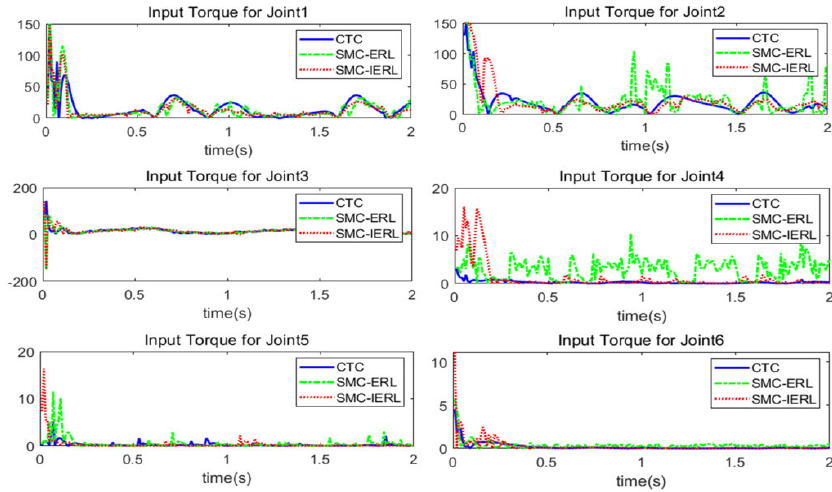
Figure 5. In the uniform circular trajectory experiment without considering disturbance signal, the output torque of each joint obtained by the three control algorithms is compared.